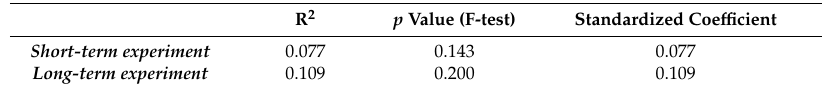
Table 5. Linear regression between the di ff erence of the calibrated BP and the cu ff -based BP and the average of these in the short-term and long-term experiments.